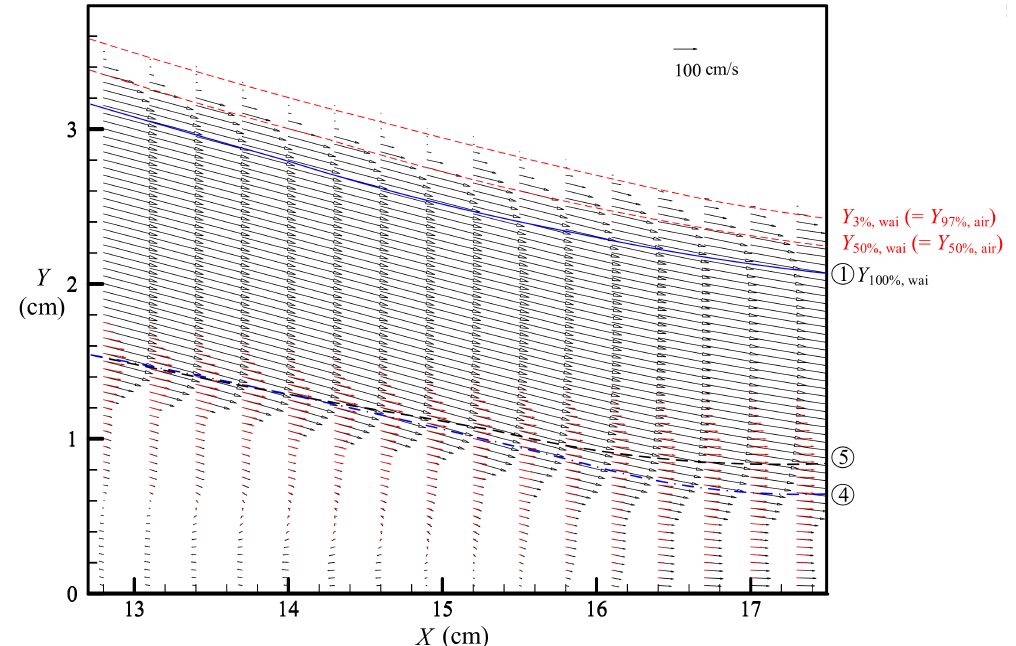
Figure 20. Two-phase velocity field consisting of the water phase/air-bubble phase velocity vectors marked by black/red